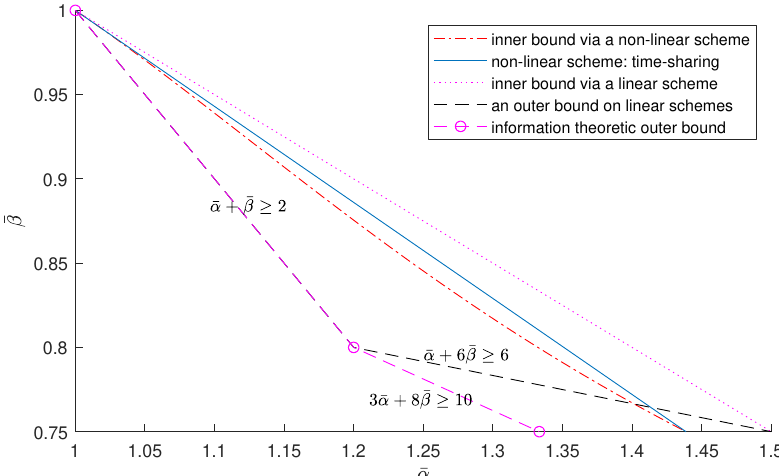
Figure 2. Illustration of inner bounds and outer